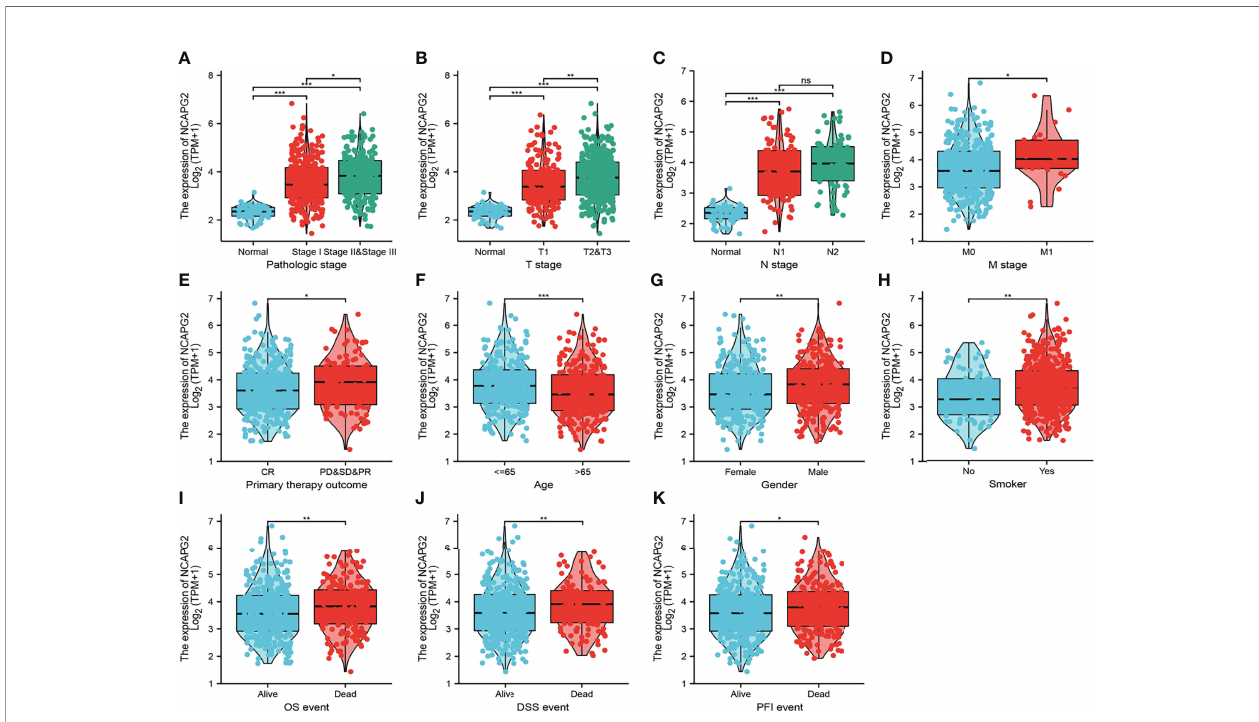
FIGURE 3 | Clinical signi fi cance of NCAPG2 in lung adenocarcinoma. Correlation between NCAPG2 expression and clinical parameters, including (A) pathological stage, (B – D) TNM stage, (E) primary therapy outcomes, (F) age, (G) gender, (H) smoker, (I – K) OS event, DSS event, and PFS event. Primary therapy outcome: PD, progressive disease; SD, stable disease; PR, partial response; CR, complete response. NS, p > 0.05, * p <0.05, ** p <0.01, *** p